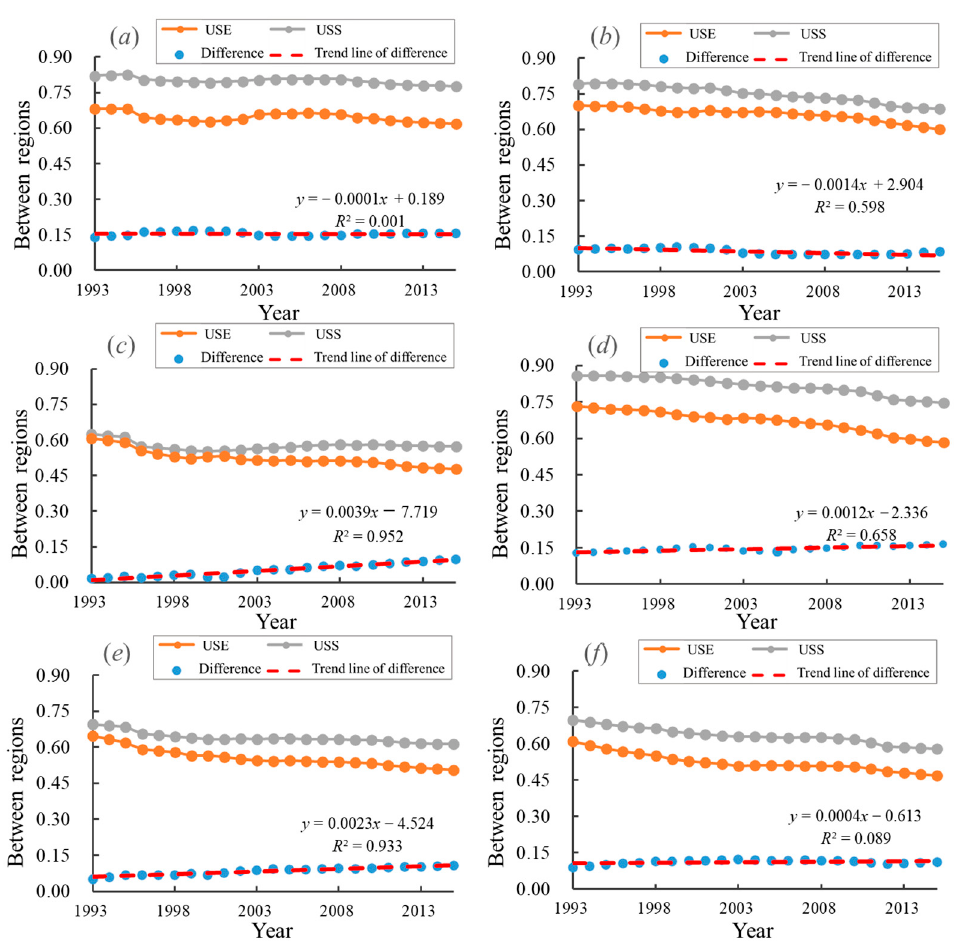
Figure 10. Differences between USS and USE between regions: ( a ) NER-ER, ( b ) CR-ER, ( c ) CR-NER, ( d ) WR-ER, ( e ) WR-NER, ( f ) WR-CR. Note: USS is urban spatial expansion, and USE is urban socioeconomic expansion.